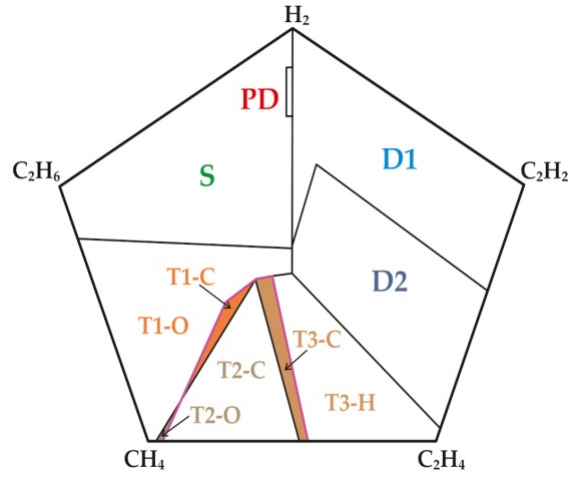
Figure 3. Duval Pentagon Combined with the ten fault zones. Table 7. Defining the areas of thermal faults in the Combined Duval